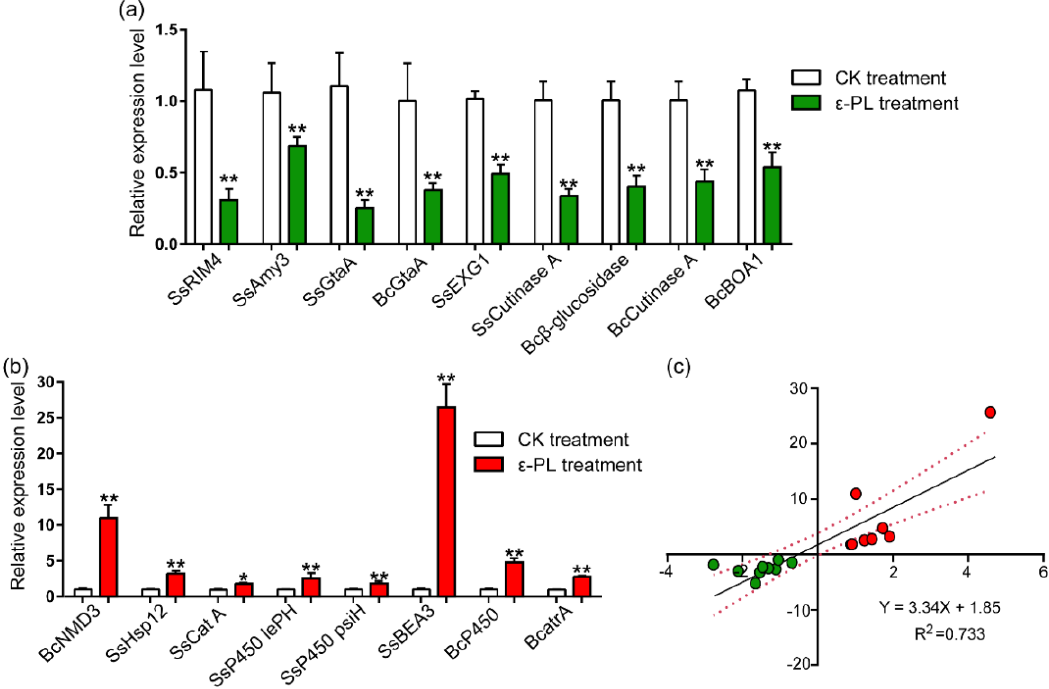
Figure 6. RT-qPCR verification of the regulation of 17 DEGs from ε -PL-treated Sclerotinia sclerotiorum or Botrytis cinerea. ( a ) DEGs mainly involved in fungal growth, or metabolites and pathogenicity, were down-regulated by ε -PL. ( b ) DEGs mainly involved in fungal stress response and detoxification were up-regulated by ε -PL. ( c ) Regression analysis of RNA-seq (independent variable) and RT-qPCR (dependent variable) data to evaluate their correlation by GraphPad Prism 7. Asterisk “*” indicated significant difference ( p < 0.05) and “**” indicated extremely significant difference ( p < 0.01) by ε -PL treatment compared with control treatment. Red color represents up-regulated genes while green color represents down-regulated genes.